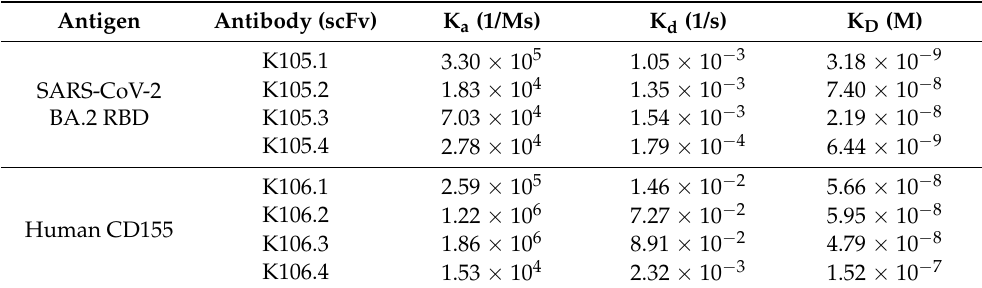
Figure 10. Position-specific amino acid frequencies of somatic hypermutations at each complementarity-determining region position in heavy chain variable (VH) and κ light chain variable (V κ ) domain of the constructed library. The stacked column diagram shows the frequency and composition of mutations that occurred in each VH ( A ) and Vκ ( B ) sequence, respectively. The x axis shows the amino acid position of each variable domain, as defined by Kabat numbering. Table 1. Biochemical characterization of the selected phage display-derived single-chain variable fragments specific to therapeutically relevant target